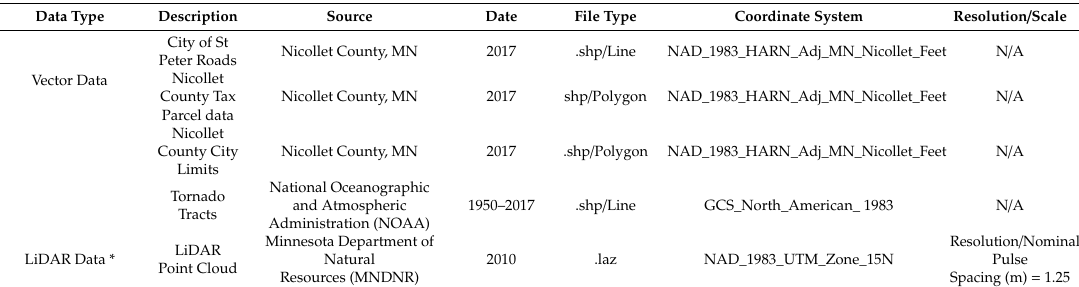
Table 2. Vector and LiDAR